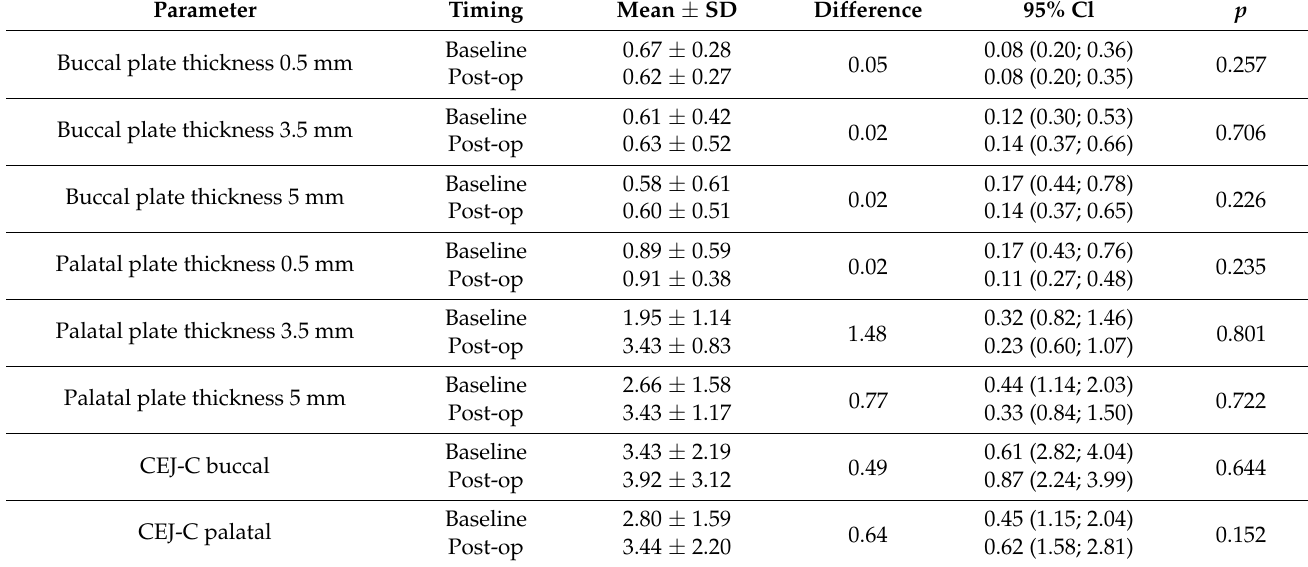
Table 4. Distribution of CBCT parameters for canines before and after orthodontic